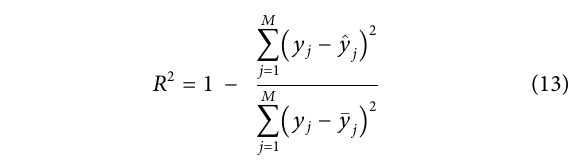
FIGURE 10 | The absolute error box diagram for MG.